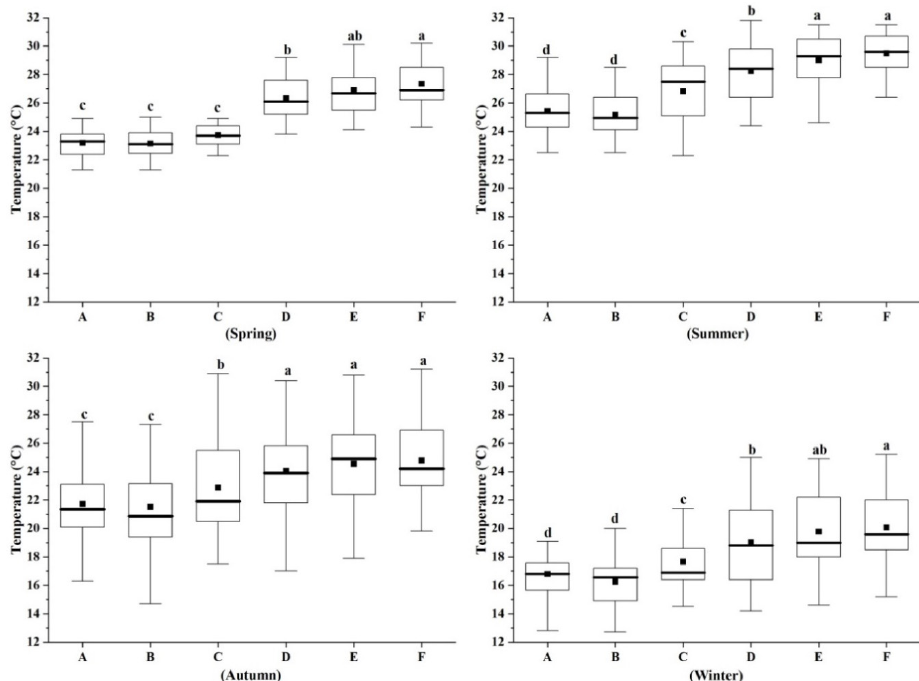
Figure 7. The temperature changes of different forest types in different seasons. A— Phyllostachys edulis forest; B—Subtropical evergreen broad-leaved forest; C—Forestless control group; D— Liquidambar formosana forest; E— Cunninghamia lanceolata forest; F—Coniferous and broad-leaved mixed forest. The different lowercase letters indicate significant difference among the stand types in the same time ( p < 0.05).